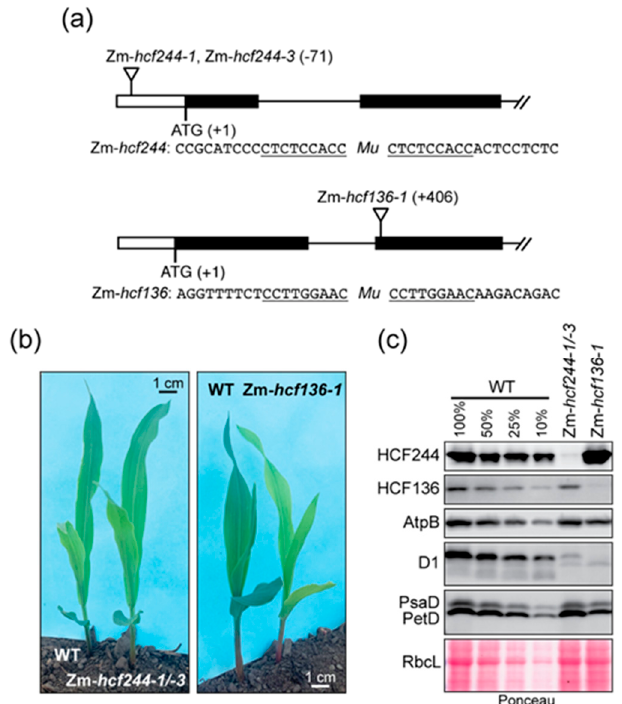
Figure 1. Maize mutants used in this study. ( a ) Insertion sites of Mu transposons in Zm- hcf244 and Zm- hcf136 mutants. The Zm- hcf244-1 and Zm- hcf244-3 alleles arose independently but have an insertion at the same position. The sequences flanking each insertion are shown below, with the target site duplications underlined. ( b ) Mutant seedlings and their phenotypically normal siblings at the developmental stage used for experiments reported here. Plants were grown in soil for eight days as described in Materials and Methods. Zm- hcf244-1 / -3 is the progeny of a cross between heterozygous plants harboring each allele. ( c ) Immunoblot analysis of leaf proteins in Zm- hcf24 4 and Zm- hcf136 mutants. Replicate blots were probed to detect HCF244, HCF136, AtpB (subunit of the chloroplast ATP synthase), D1, PsaD (subunit of PSI), and PetD (subunit of the cytochrome b 6 f complex). An excerpt of one of the Ponceau S-stained blots illustrates relative sample loading and the abundance of the large subunit of Rubisco (RbcL).